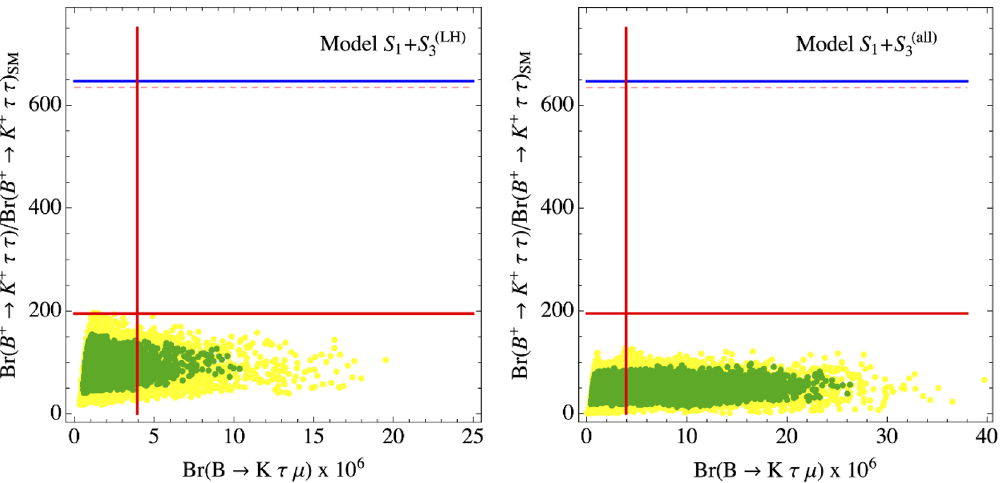
Figure 8 . Results from the fit in the S 1 + S (LH) panel). The red solid (dashed) lines correspond to the 50 ab − 1 ( 5 ab − 1 ) Belle II future bounds, at 95% C.L. . The blue solid line is the prospected bound for the LHCb Upgrade II, on Br ( B s → ττ ) / Br ( B s → ττ ) SM